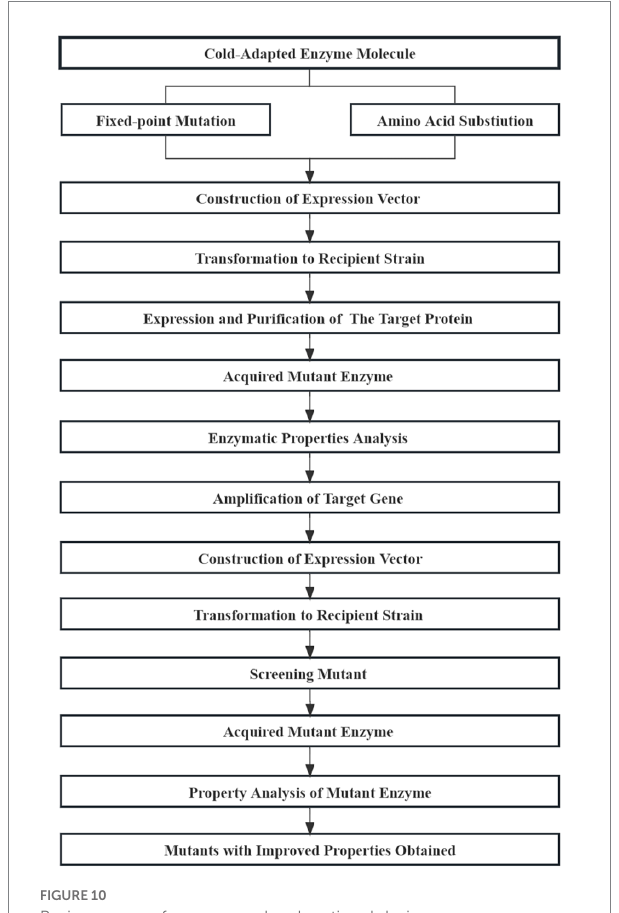
FIGURE 10 Basic process of enzyme molecule rational